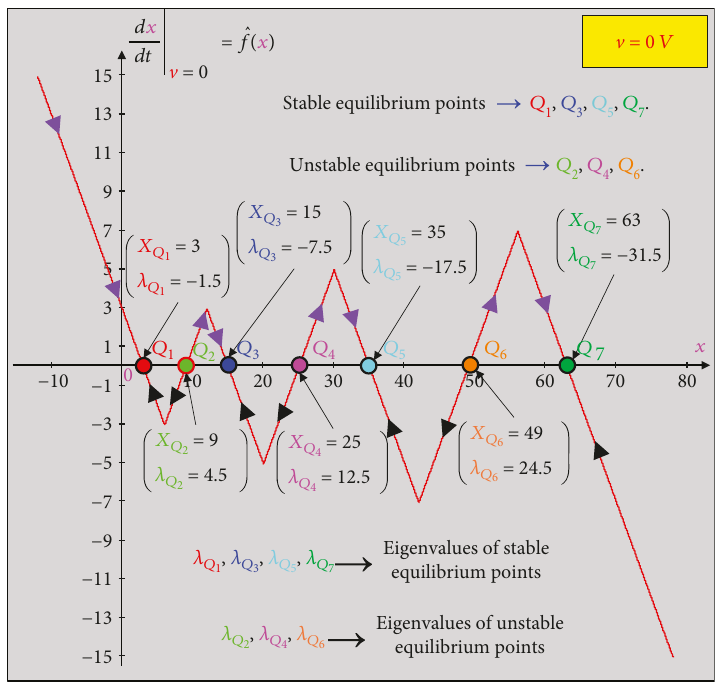
Figure 2: Dynamic route map of the 6-lobe Chua corsage memristor at V =0 V is called the power-o ff -plot ( POP